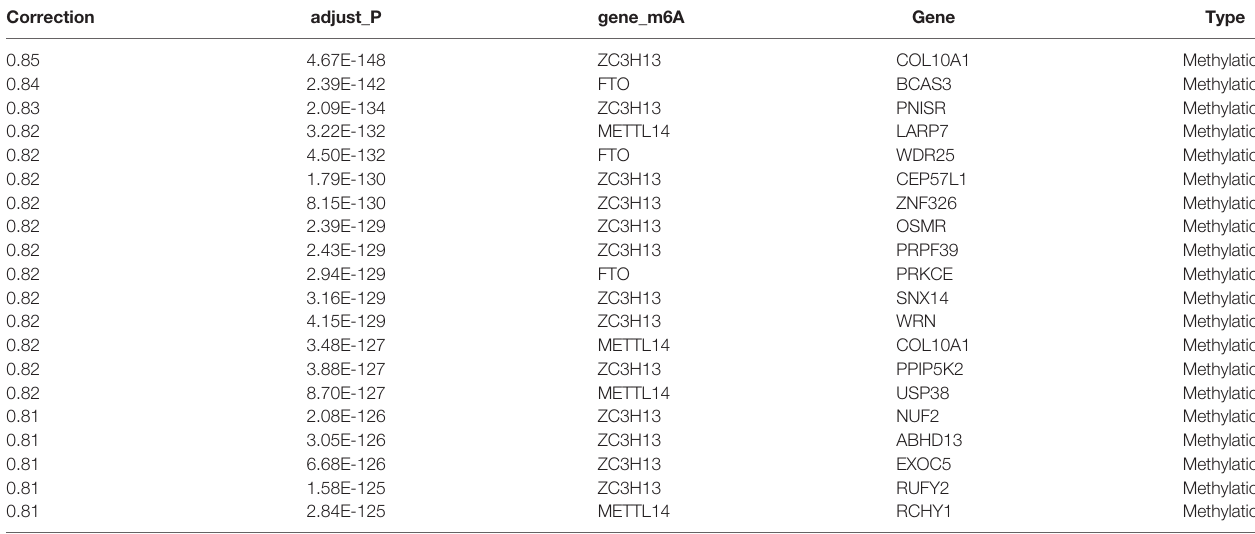
TABLE 3 | Genes were signi fi cantly correlated at the methylation level (top